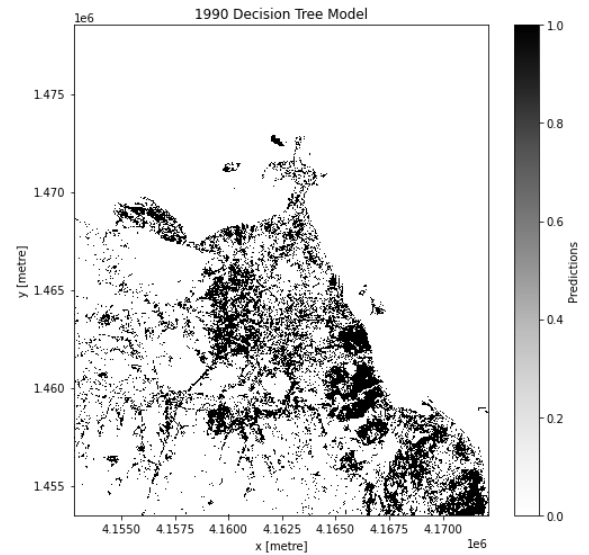
Figure 4. Initial results of the 1990 decision tree model.